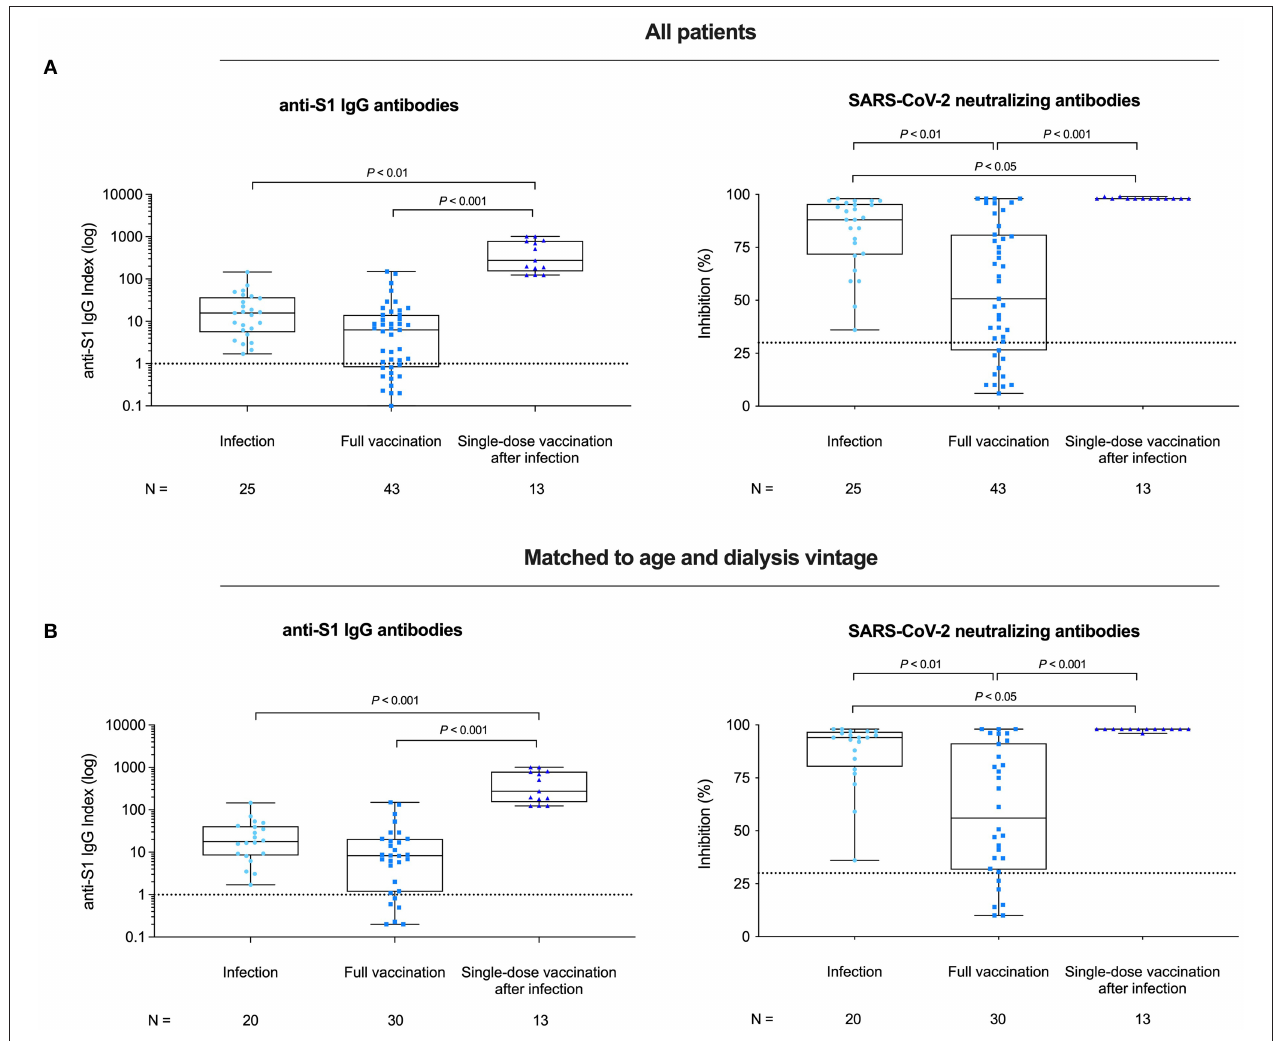
FIGURE 2 | Spike antigen-specific SARS-CoV-2 IgG levels and SARS-CoV-2 neutralizing capacity in hemodialysis patients after COVID-19 infection, complete BNT162b2 vaccination, and in previously infected patients receiving a single dose of BNT162b2. SARS-CoV-2 IgG antibodies and SARS-CoV-2 neutralizing capacity of vaccine-induced antibodies in all (A) and in age- and dialysis vintage-adjusted patients (B) for COVID-19 infected patients, patients receiving complete BNT162b2 vaccination and for previously COVID-19 infected patients receiving a single dose of BNT162b2, respectively. SARS-CoV-2 IgG antibodies are represented logarithmically as an anti-S1 IgG index. The dashed line represents the cutoff for SARS-CoV-2 IgG antibody detection with a semi-quantitative index of < 1 classified as negative, and a value of β ≥ 1 or higher classified as positive. SARS-CoV-2 neutralizing capacity of BNT162b2 induced antibodies was determined by a virus neutralization test and antibody-mediated inhibition of the SARS-CoV-2 receptor-binding domain:angiotensin-converting enzyme 2 interaction is expressed as a percentage. Binding inhibition > 30% indicates presence of SARS-CoV-2 neutralizing antibodies above the limit of detection of this